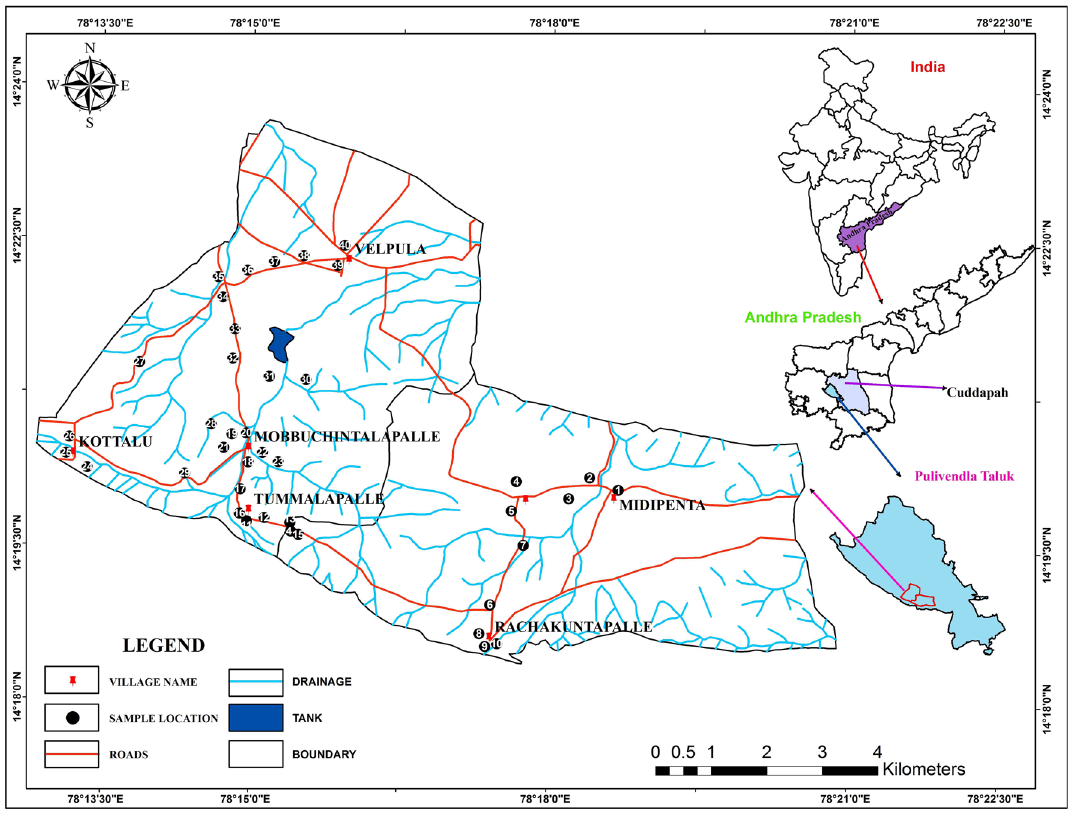
Fig. 1 Map of study area showing sampling